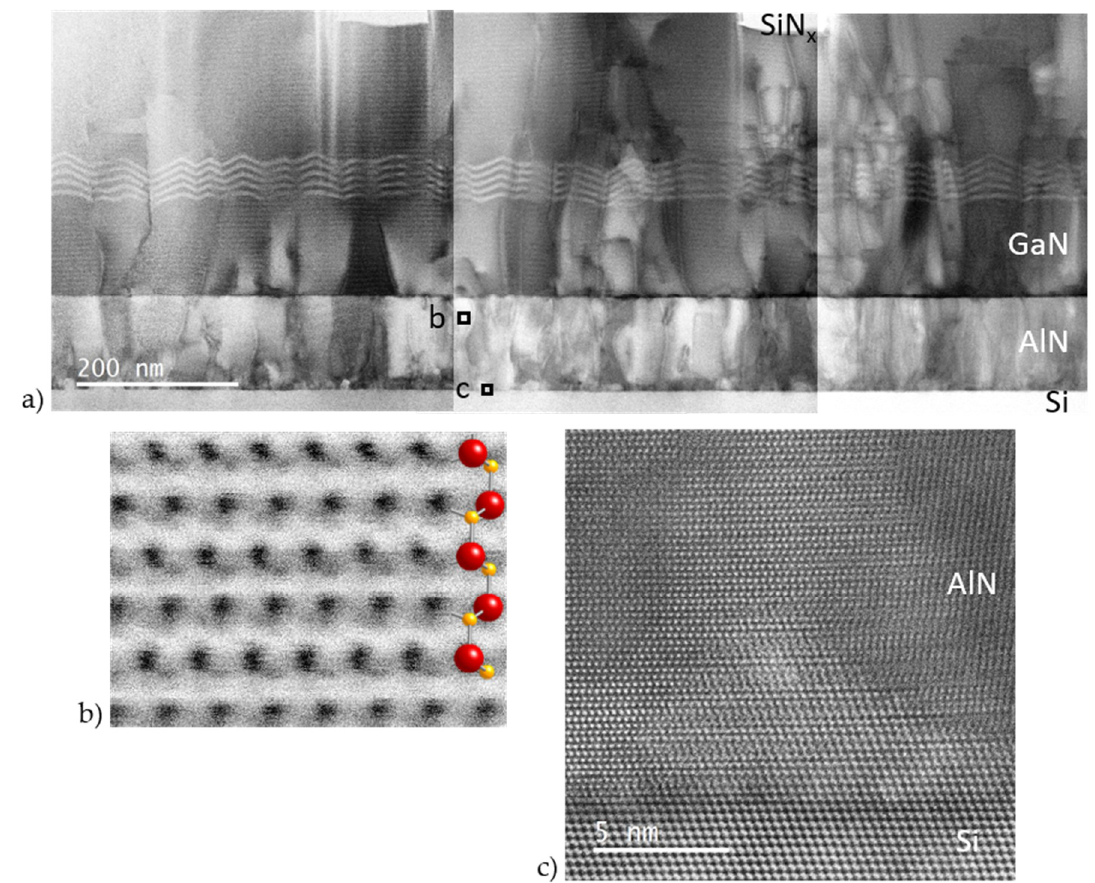
Figure 6. ( a ) and ( b ) STEM ABF images of the Ga-polar buffer for Ga–AlGaSL: ( a ) lower magnification composite image showing threading dislocations and mosaic structure in the Al-polar AlN, which propagate into the GaN buffer; ( b ) atomic resolution STEM ABF image showing Al-polarity in the AlN buffer (top box in ( a )); and ( c ) atomic scale STEM HAADF image of an Si hillock above the substrate plane at the Si/AlN interface (bottom box in ( a )), similar to that in Figure 4d.